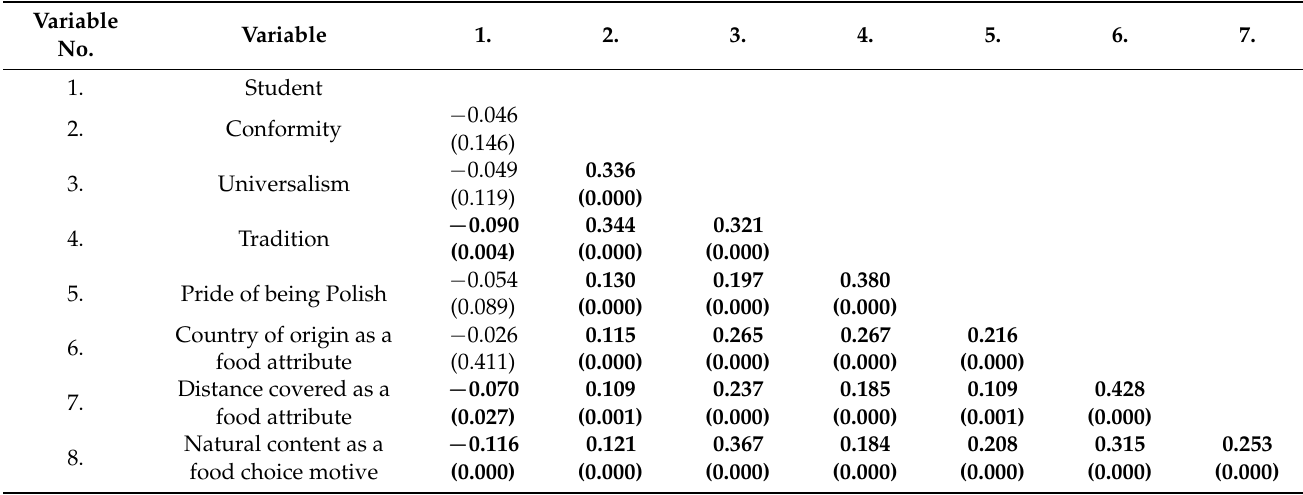
Table 5. Correlation matrix for predictors of consumer ethnocentrism in the food market used in the retrograde stepwise regression model in the total